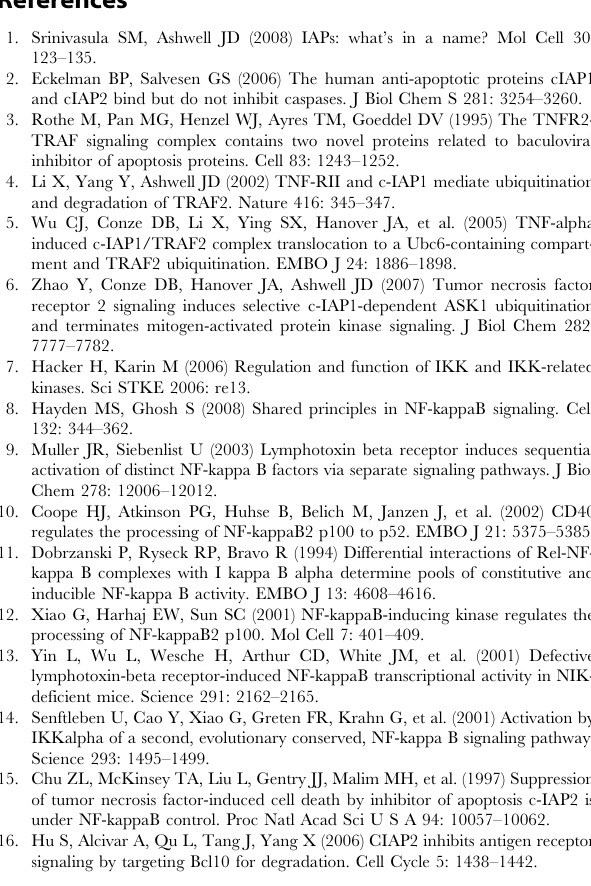
Figure S6 Binding of in vitro translated and